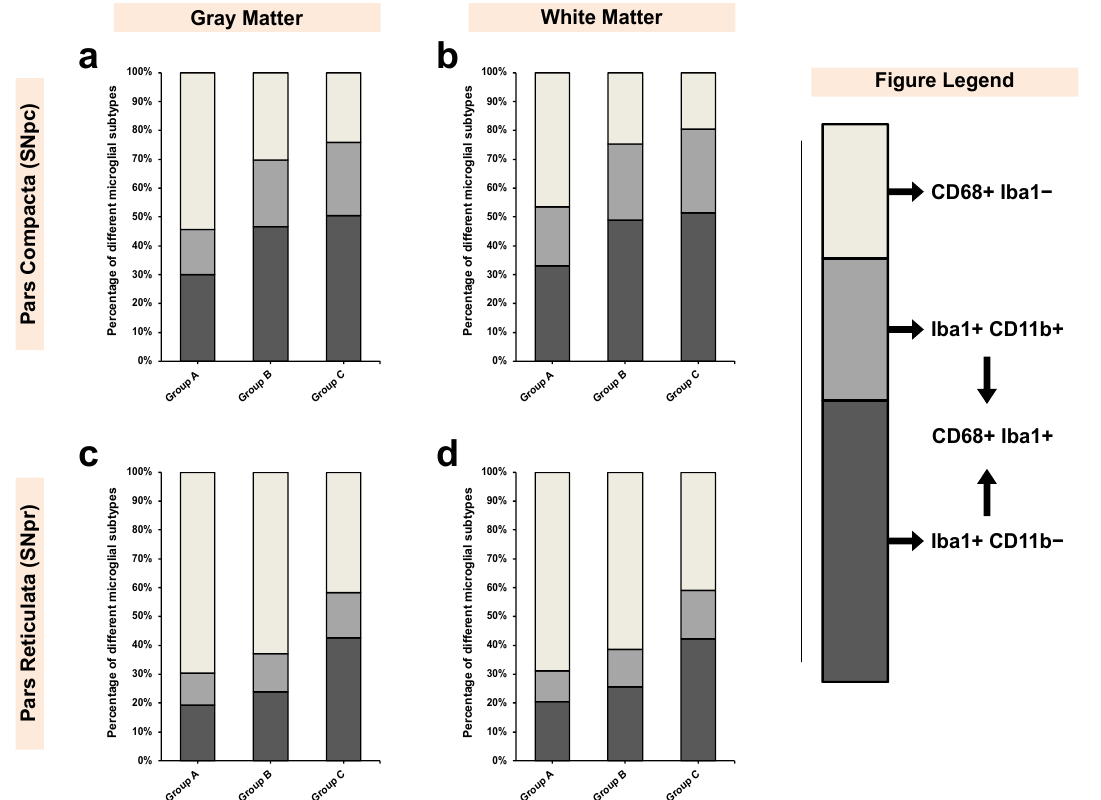
Figure 7. Distribution of different microglial subpopulations (in %) in both SNpc and SNpc for all three groups. The data has been shown for ( a , c ) gray and ( b , d ) white matter. The figure legend describes the various subpopulations identified including CD68+/Iba1 − and CD68+/Iba1+. Within CD68+/Iba1+, two subtypes were identified namely, Iba1+/Cd11b+ and Iba1+/CD11b − .